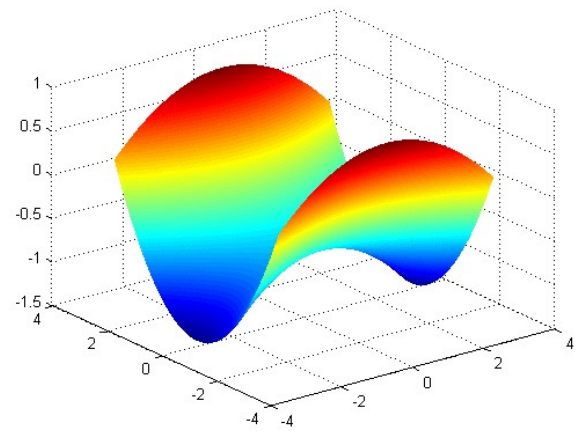
Figure 6. The graph of function F 2 .